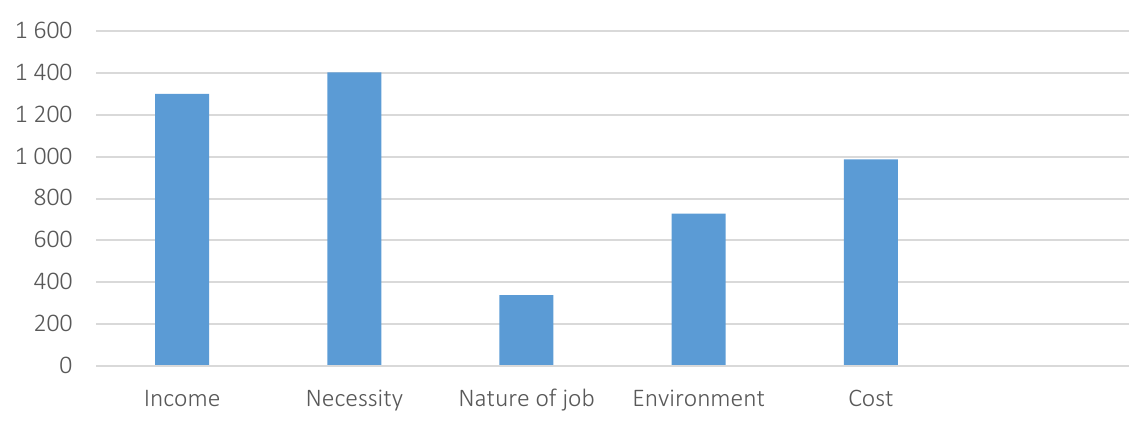
Figure 2. Factors influencing the choice of